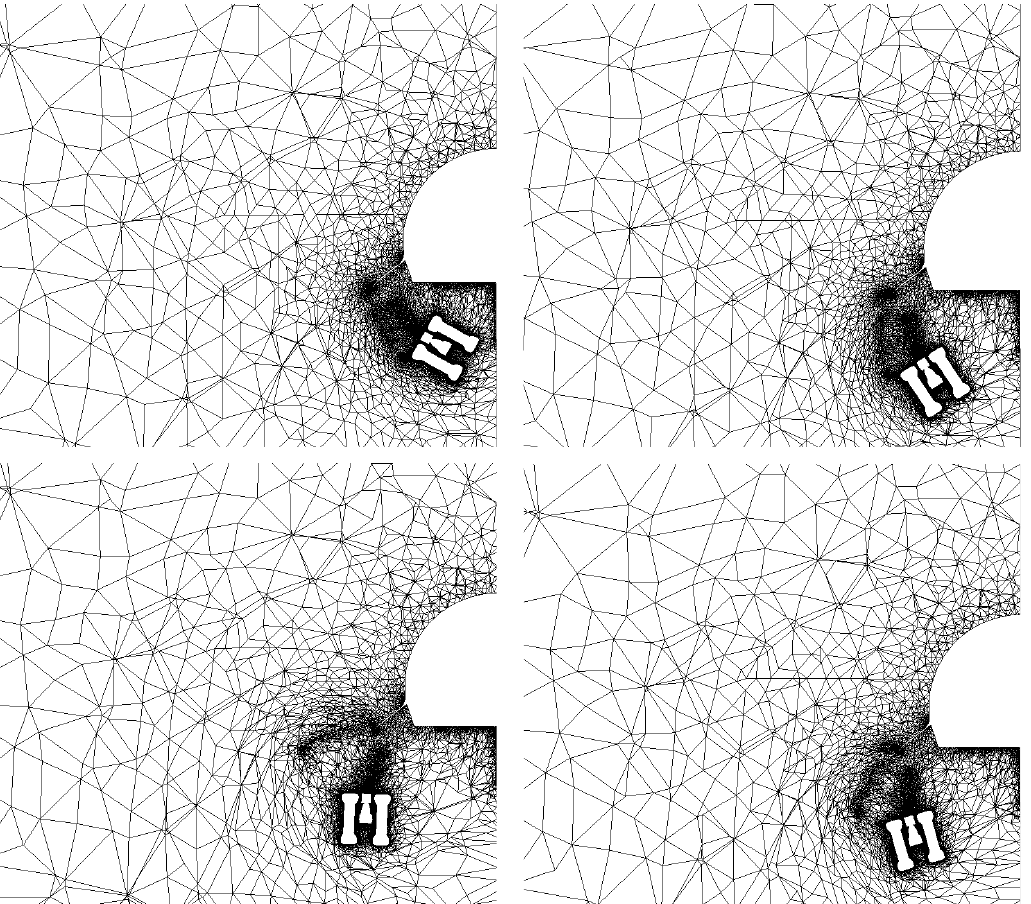
Figure 14. MLG: computational mesh during the lowering phase